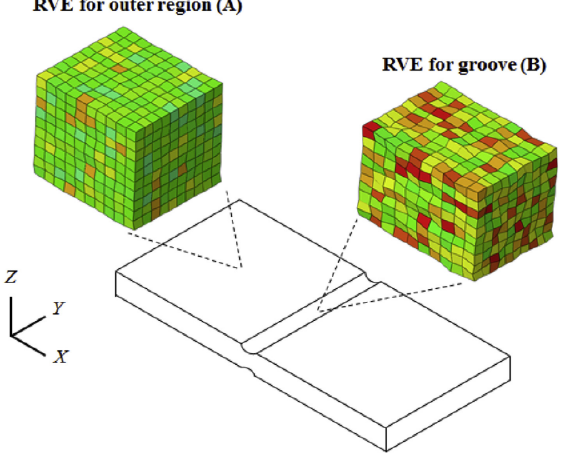
Figure 34. A schematic description of a multiscale approach that coupling the M-K model and CPFEM. Reprinted from Ref. [420] with permission. Copyright 2017, Elsevier.